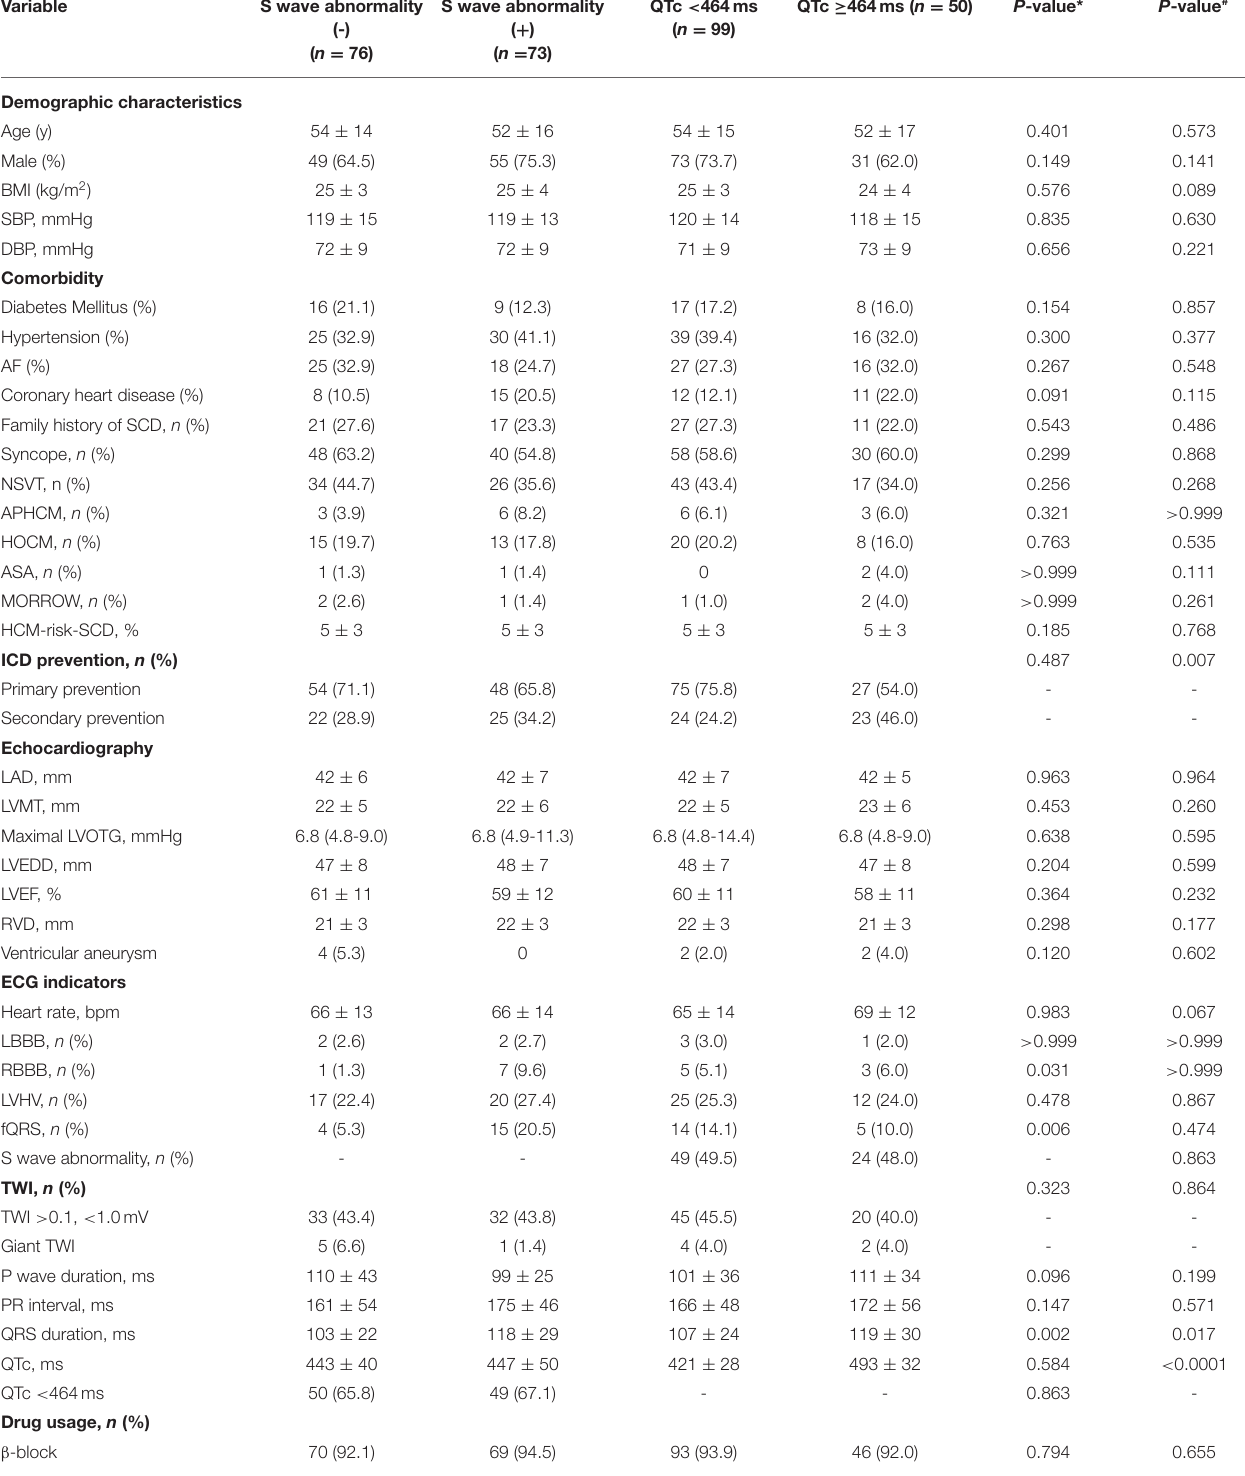
TABLE 3 | Patients stratified according to QTc interval and S wave anomalies.